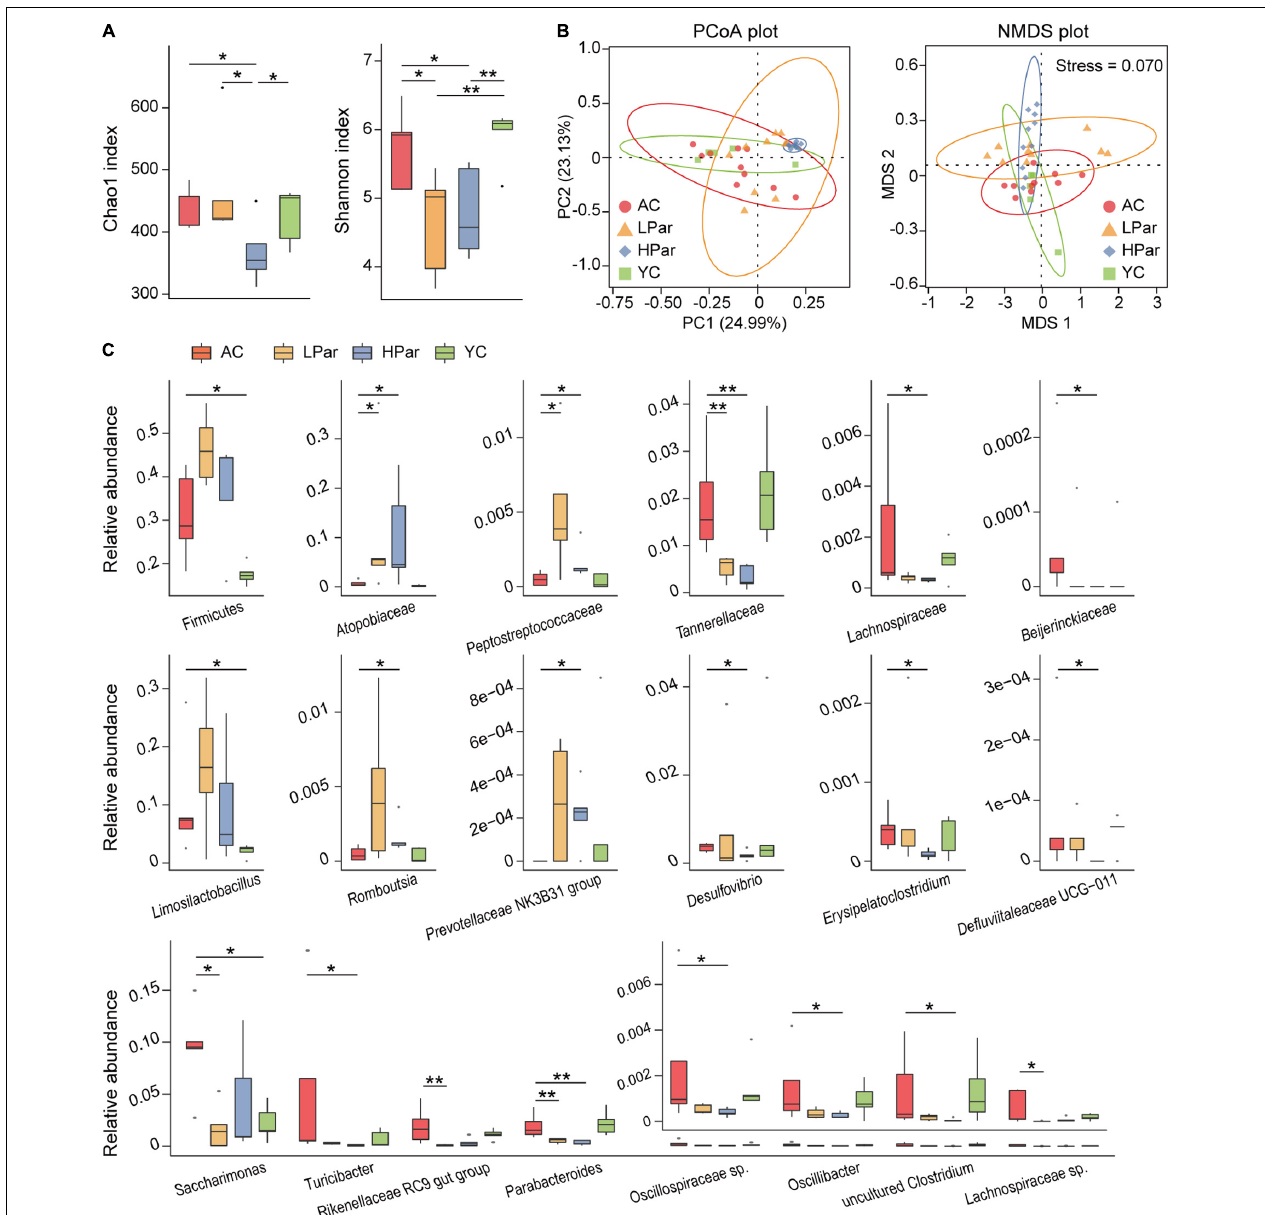
FIGURE 2 | Parishin treatment alleviates aging-induced dysbiosis of the gut microbiota. (A) Box plot of community biodiversity and richness estimated based on the Shannon indexes and Chao1 indexes. (B) Two-dimensional PCoA and NMDS plot based on the Bray–Curtis dissimilarity. (C) Alterations in the relative abundance of bacterial taxa in the AC, LPar, HPar and YC groups. * P < 0.05; ** P < 0.01.